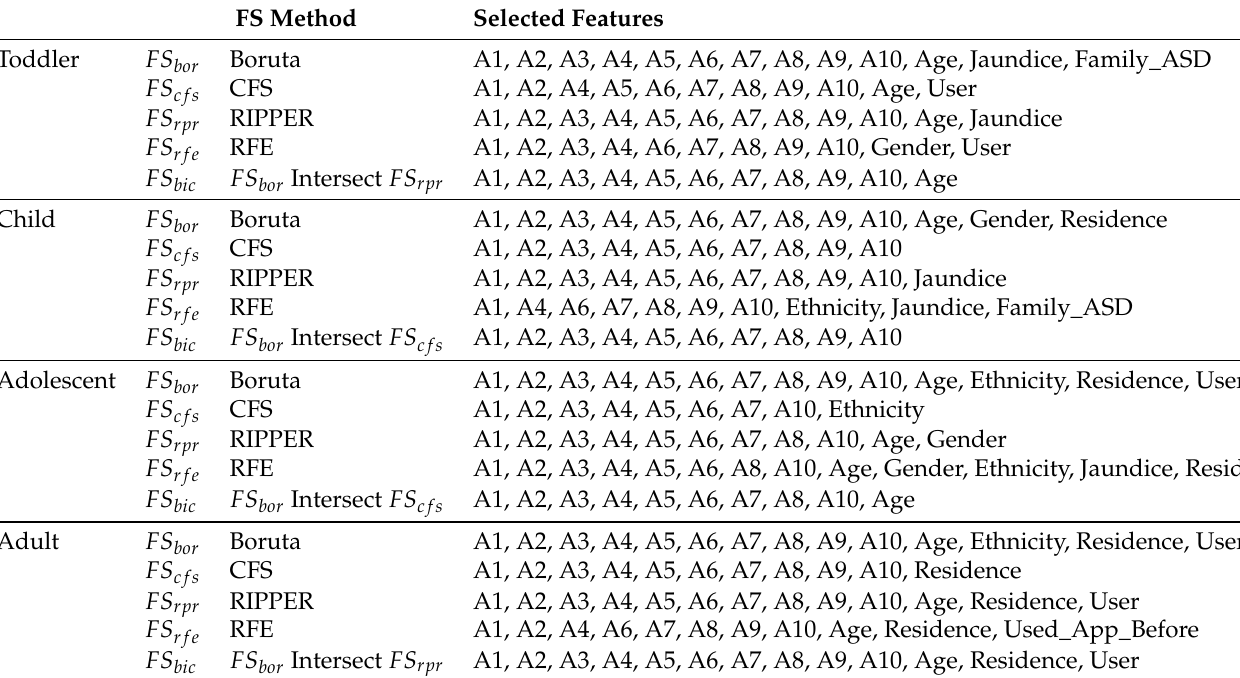
Table 4. The generated feature subsets of individual age